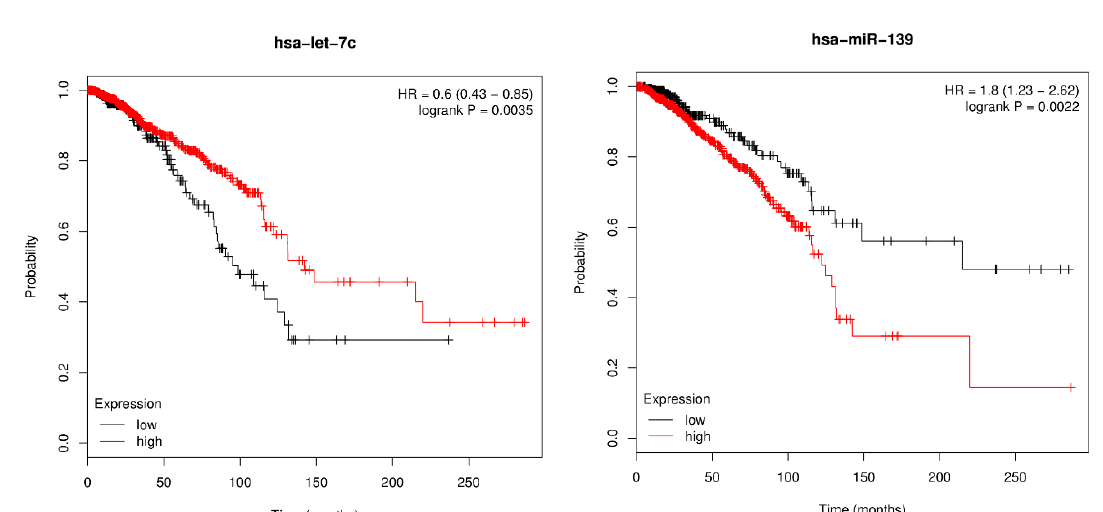
Figure 6. Kaplan-Meier plots of hsa-miR-148a, hsa-miR-133b, hsa-miR-130a and hsa-let-7e for survival of breast cancer patients.